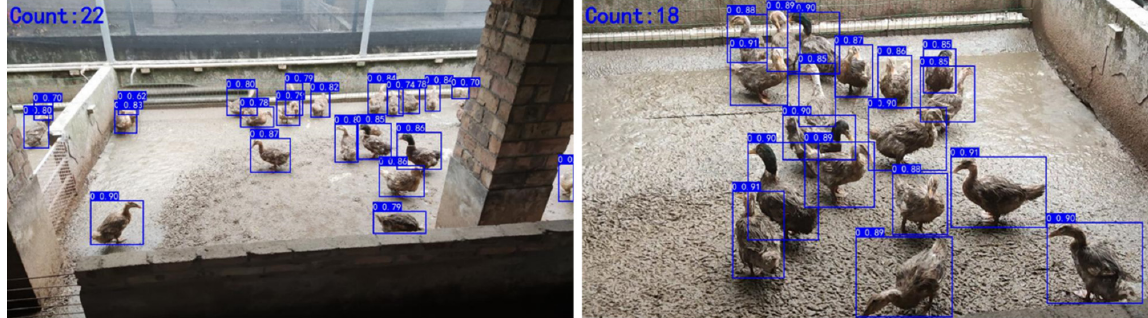
Figure 12. Yolov7 algorithm prediction chart (without